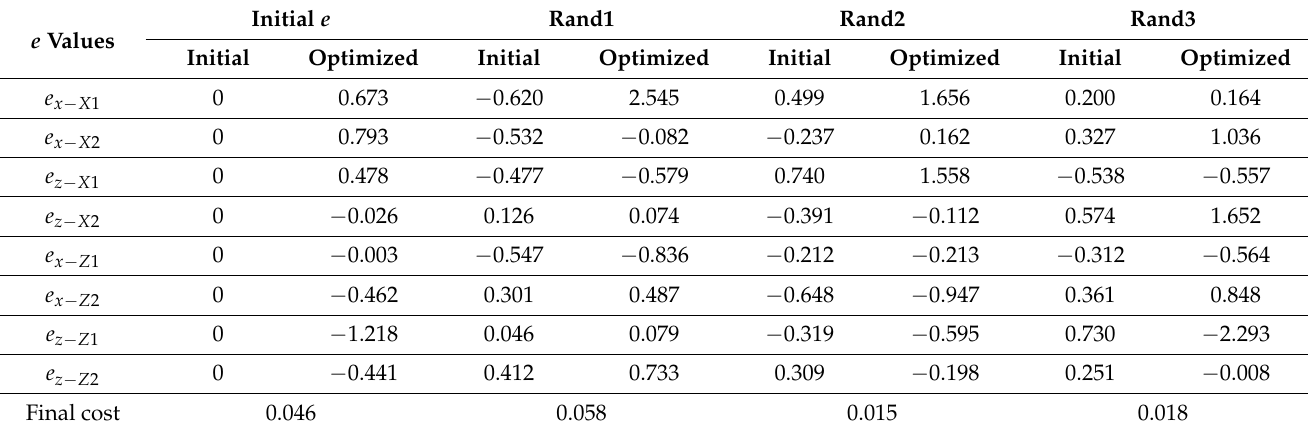
for the first cycle at 100% MS. :